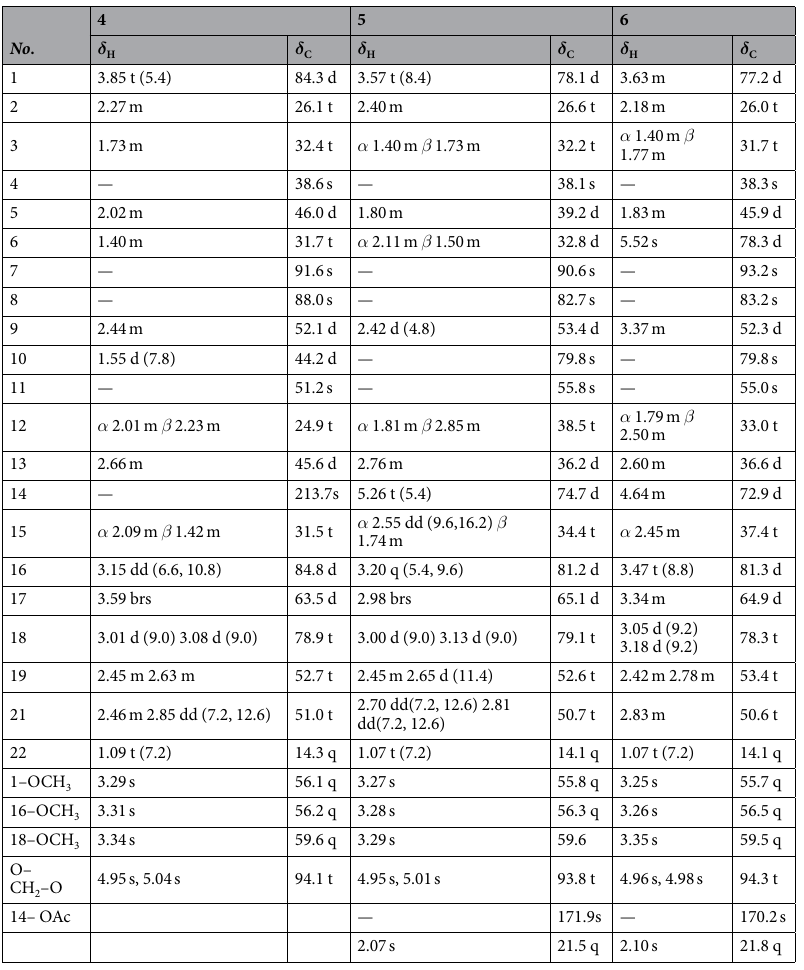
Table 2. NMR Spectroscopic Data a for Compounds 4 – 6 (600 MHz for 1 H, 150 MHz for 13 C, CDCl 3, δ ppm). a Data are based on DEPT, HMQC, and HMBC